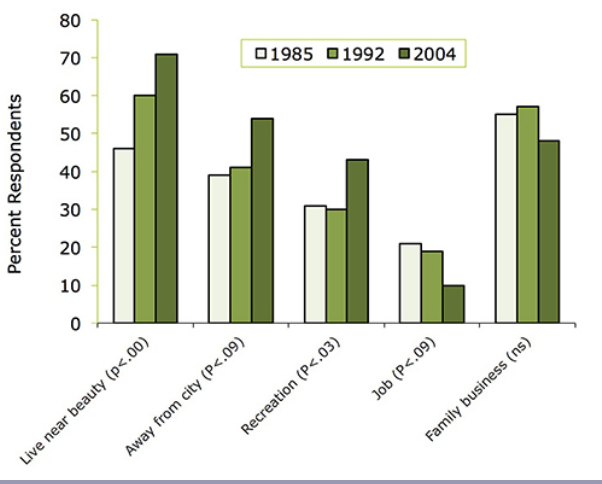
Fig. 6. Amenity and lifestyle orientations,